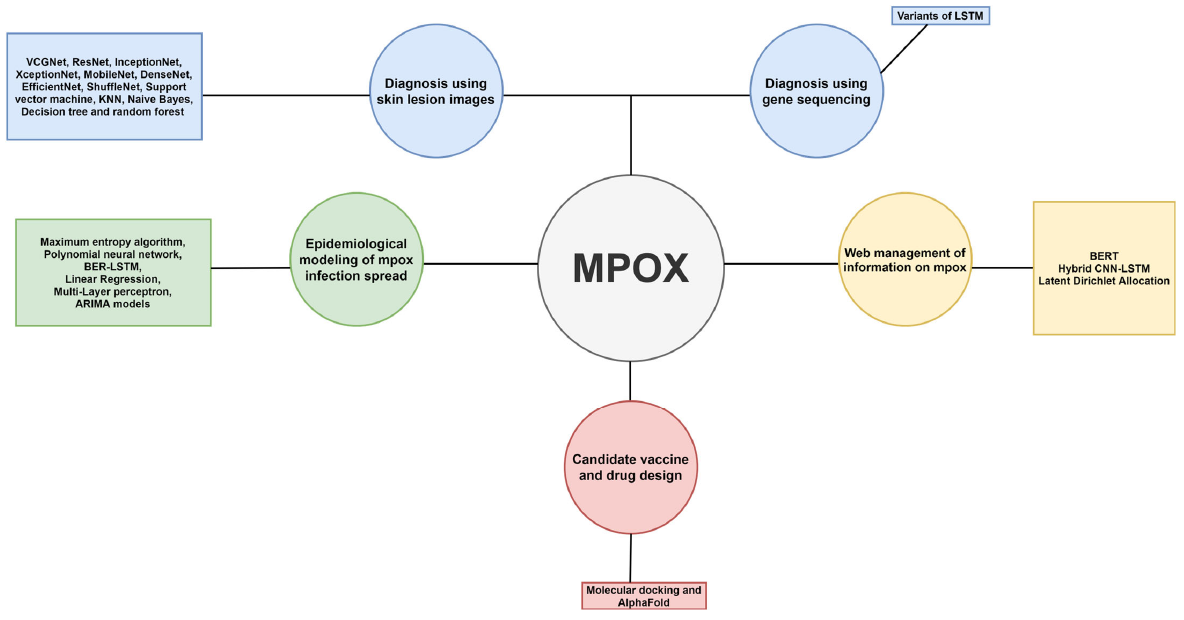
Figure 3. Overview of the structure of this review article.